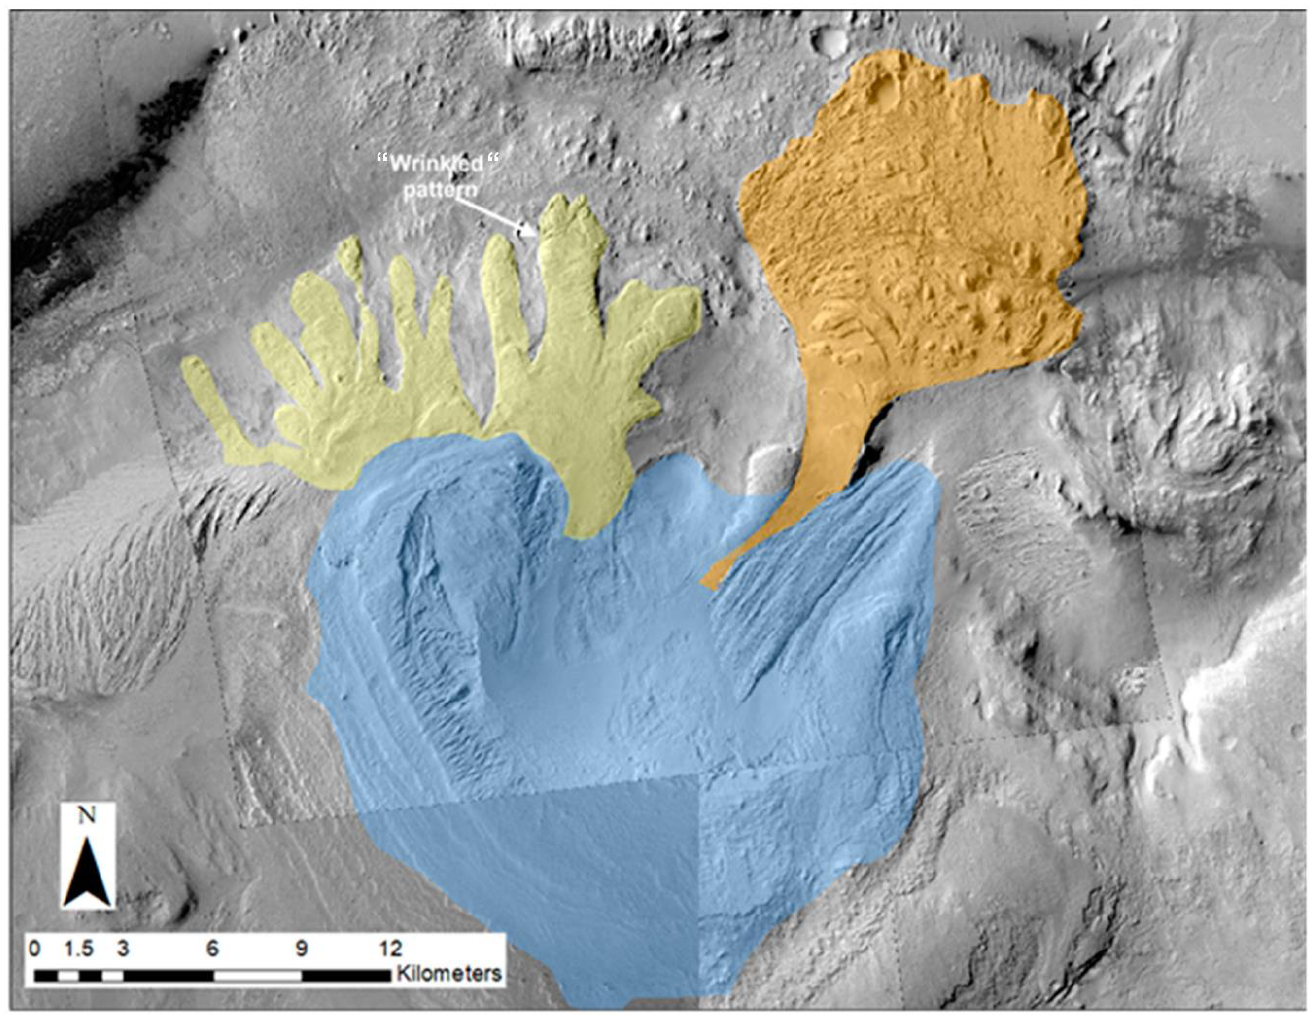
Figure 8. CTX Mosaic image of the north Mount Sharp glacial features. Yellow: Lobate Feature Complex; Orange: Spatulate feature; Blue: Concave Basin. Slope break occurs at the boundary of the concave basin and the upper edge of the lobate feature complex boundary. Background image credit: NASA/JPL-Caltech/ESA/DLR/FU Berlin.